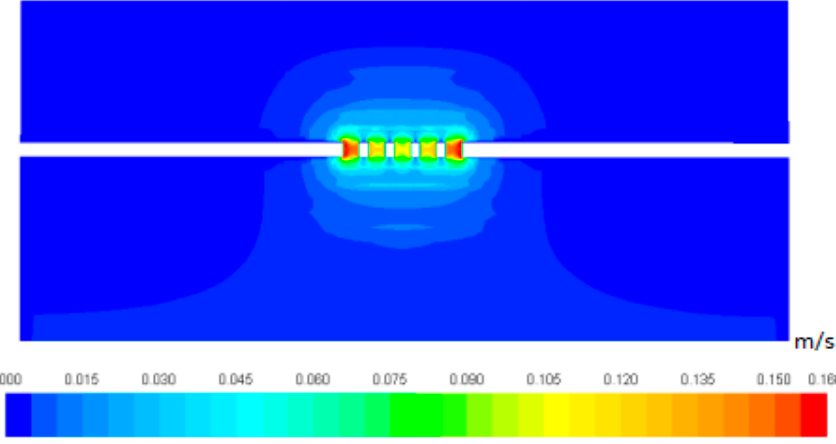
Figure 11. Acoustic velocity magnitude contour near perforated plate No. 7 absorber. Appl. Sci. 2019 , 9 , x FOR PEER REVIEW